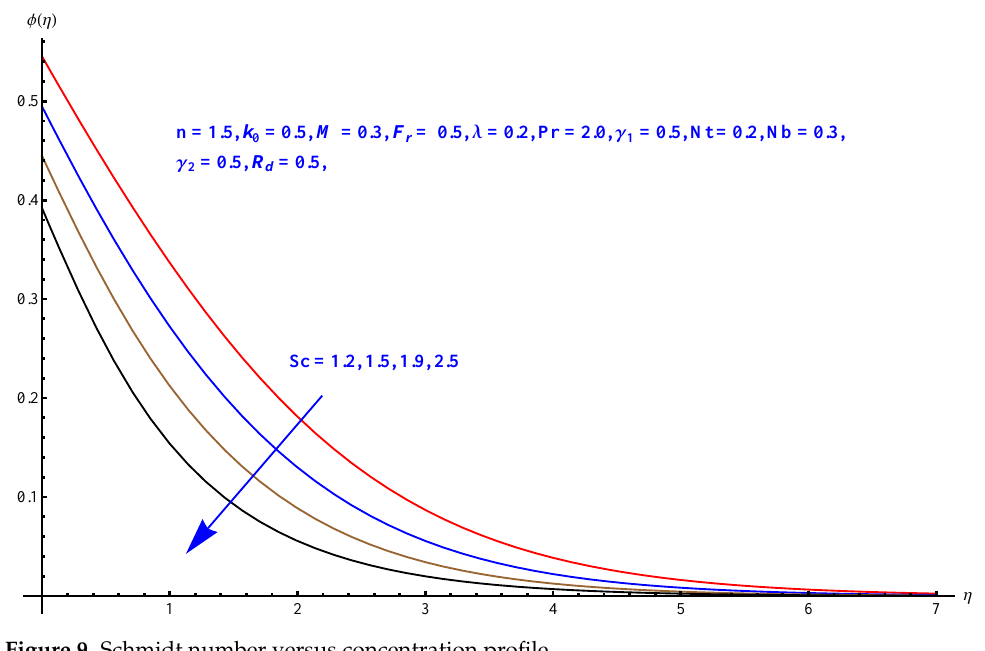
Figure 8. Brownian diffusion versus thermal profile.